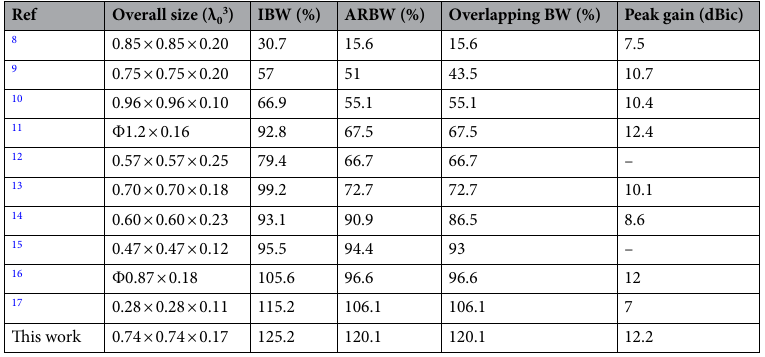
Table 2. Comparison between this work and references. λ 0 : wavelength at the lowest frequency of operation